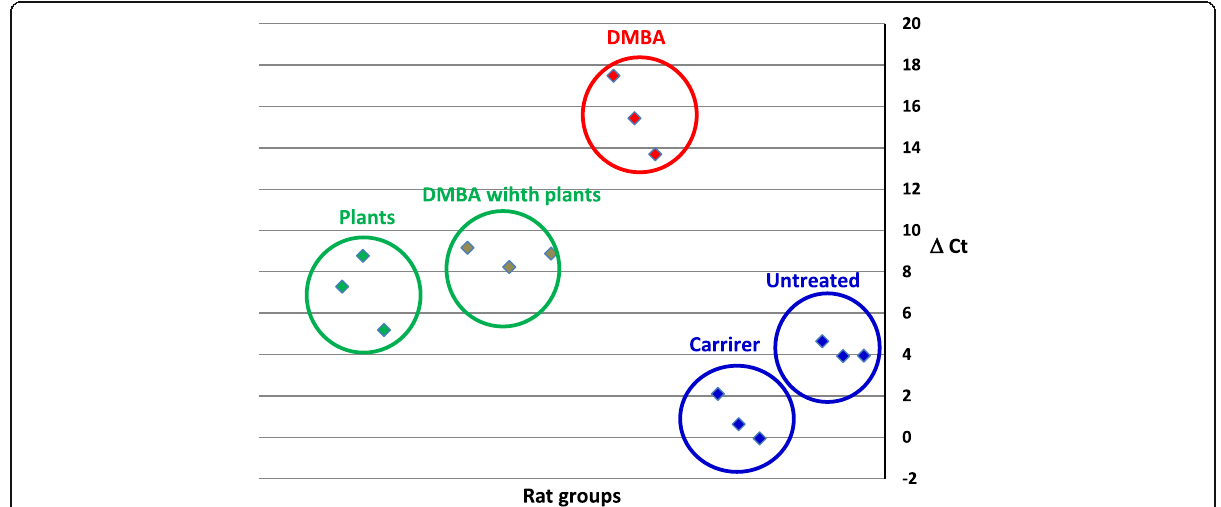
Fig. 9 Scatter plot for Δ Ct of S1PR1 expression in individual rats in the five rat groups under study